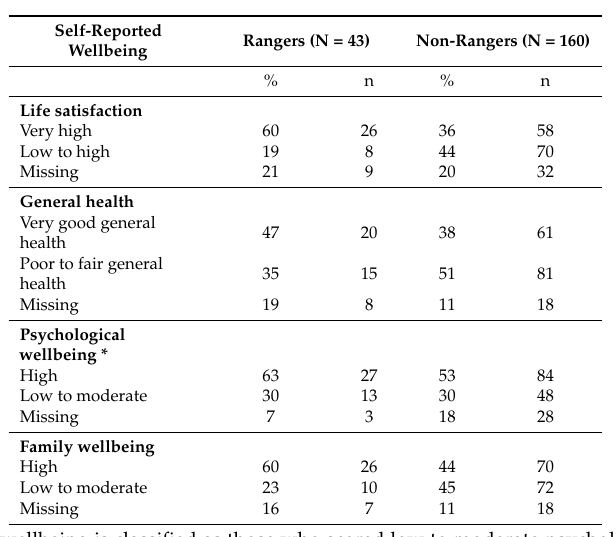
Table 3. Self-reported wellbeing, by Ranger